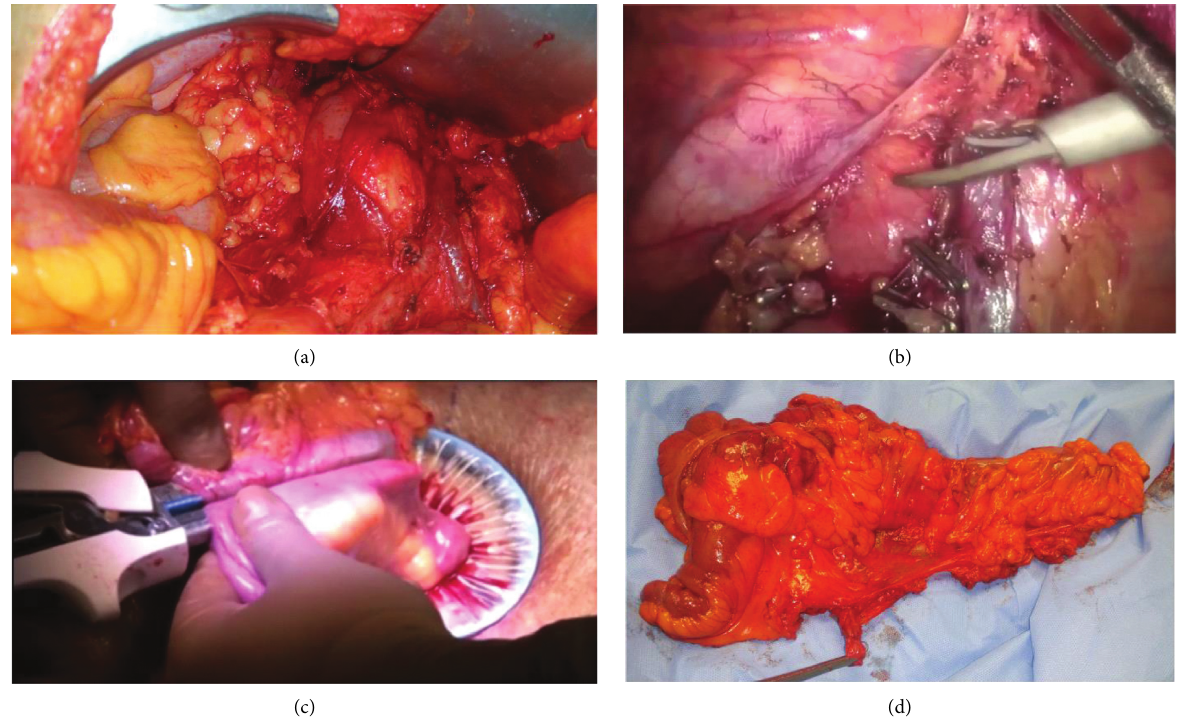
Figure 1: Surgical technique and pathologic examination. (a) Open CME with division of feeding vessels at their origin. (b) Laparoscopic CME showing clipped ileocolic vessels at their origin from superior mesenteric vessels. (c) Side-to-side stapled ileocolic anastomosis after LCME right hemicolectomy with use of wound protector. (d) CME specimen for gross pathologic assessment before